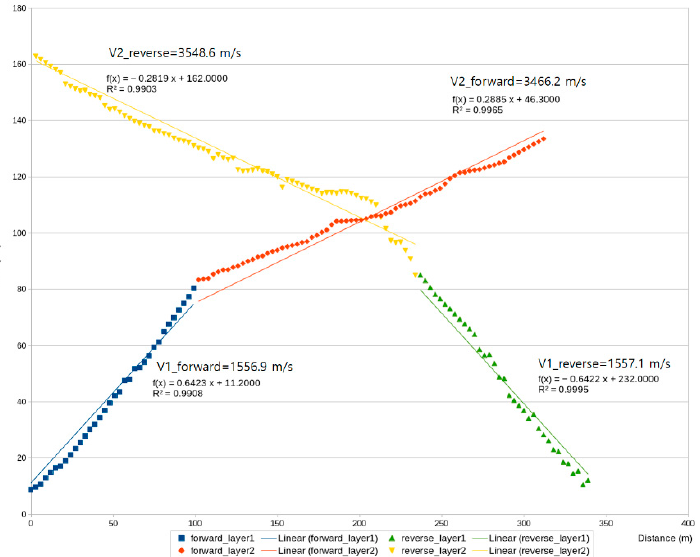
Figure 7. Calculation of velocity based on the relationship between travel time and offset distance: the forward and reverse directions indicate positive and negative offset distances, respectively.